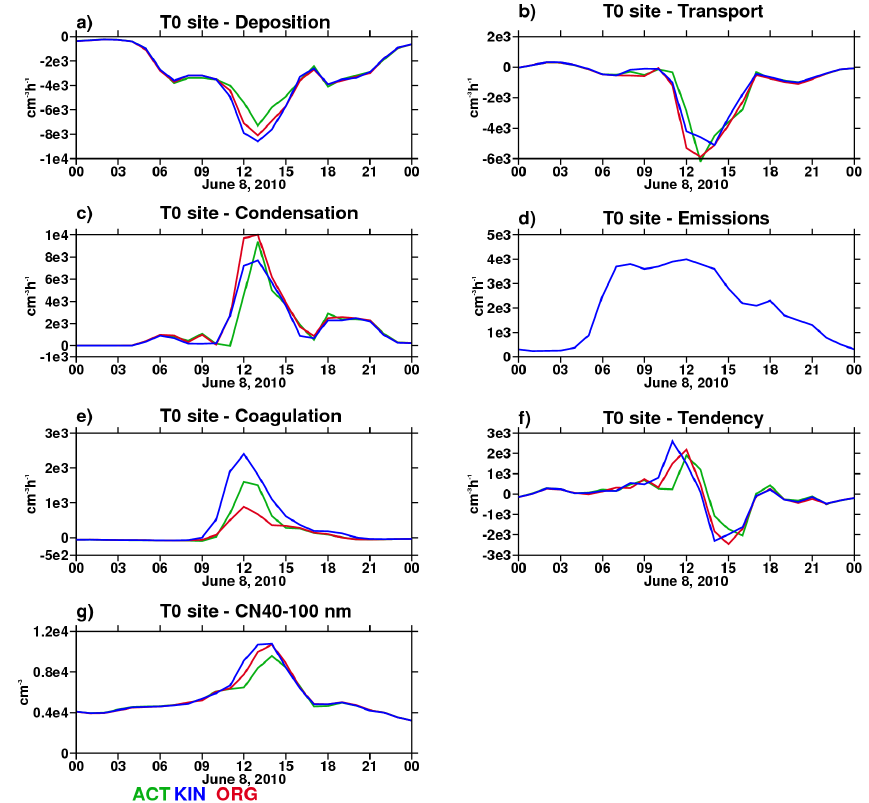
Figure 10. Budget diagnostic terms for 40–100nm particles at the T0 site on 8 June: (a) deposition; (b) transport; (c) condensation; (d) emis- sions; (e) coagulation; (f) total tendency; and (g) particle number concentration.